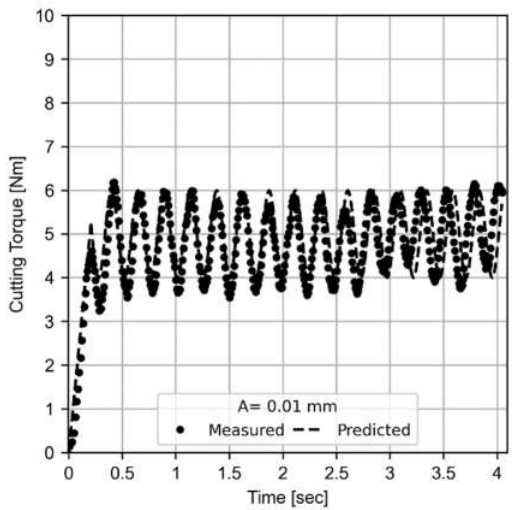
Figure 10. Measured (dot point cloud) and predicted torques (dashed line) of LFAB process with vibrational conditions (A = 0.01 mm and f = 4 Hz; test number 19 in Table